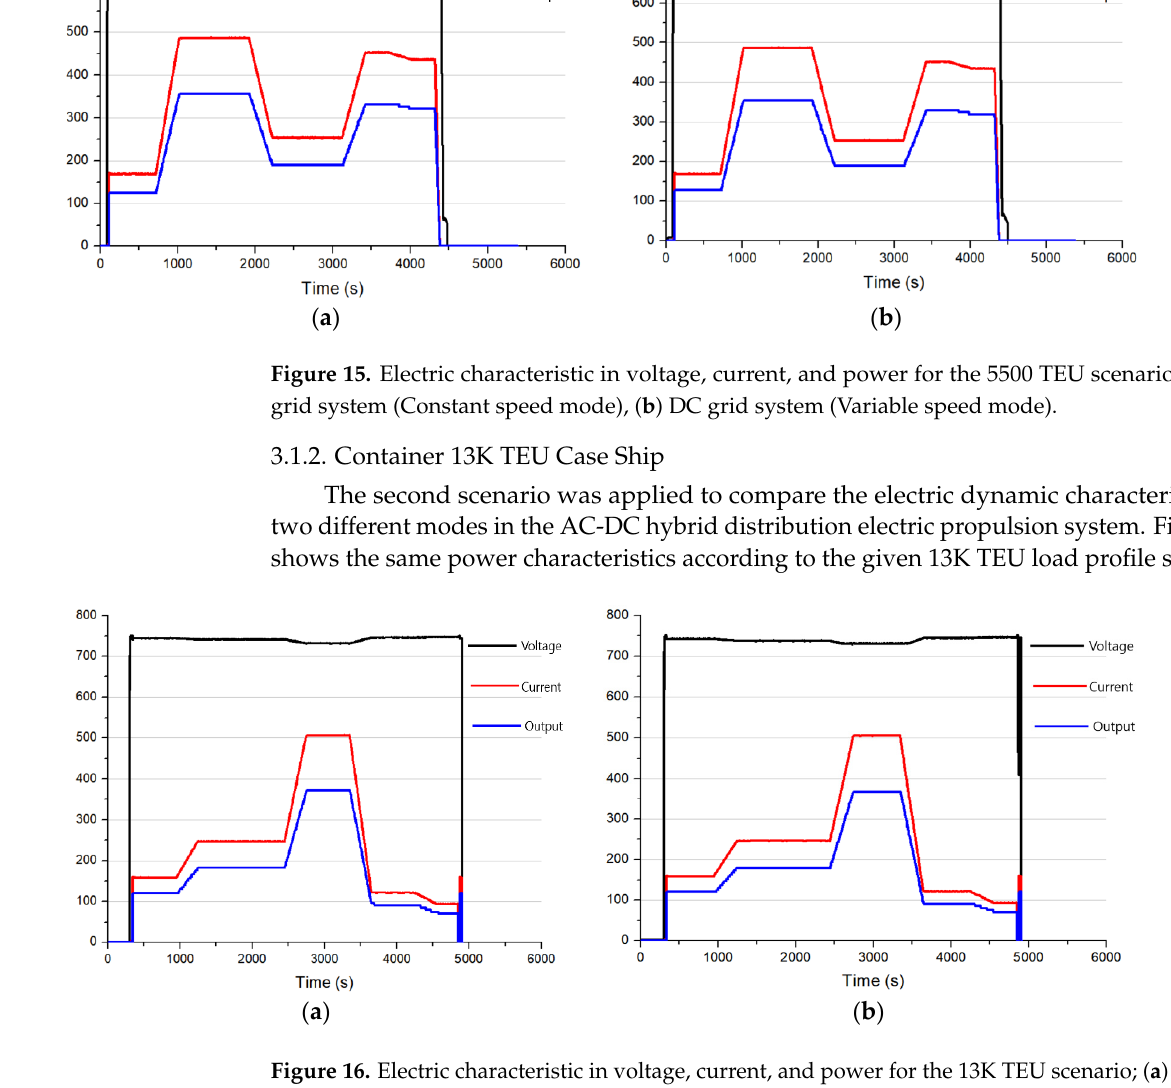
Figure 15. Electric characteristic in voltage, current, and power for the 5500 TEU scenario; ( a ) AC grid system (Constant speed mode), ( b ) DC grid system (Variable speed mode).